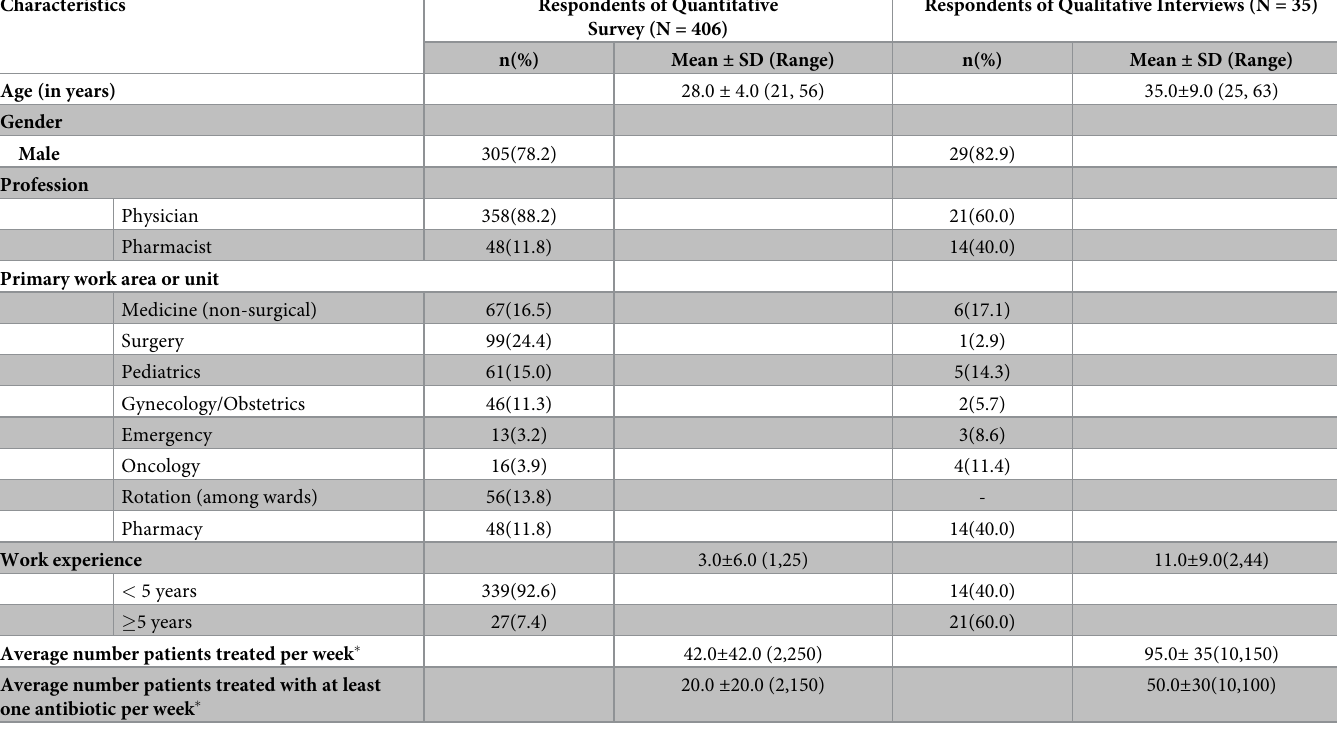
Table 1. Demographic characteristics of quantitative and qualitative study